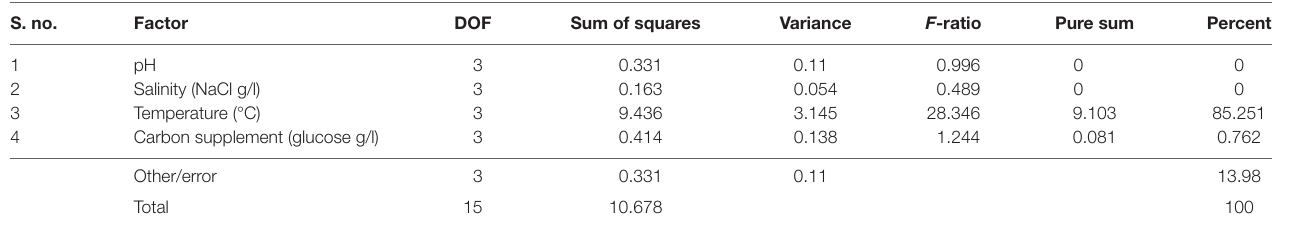
TaBle 9 | analysis of variance (anOVa) for carbohydrates production. s. no.